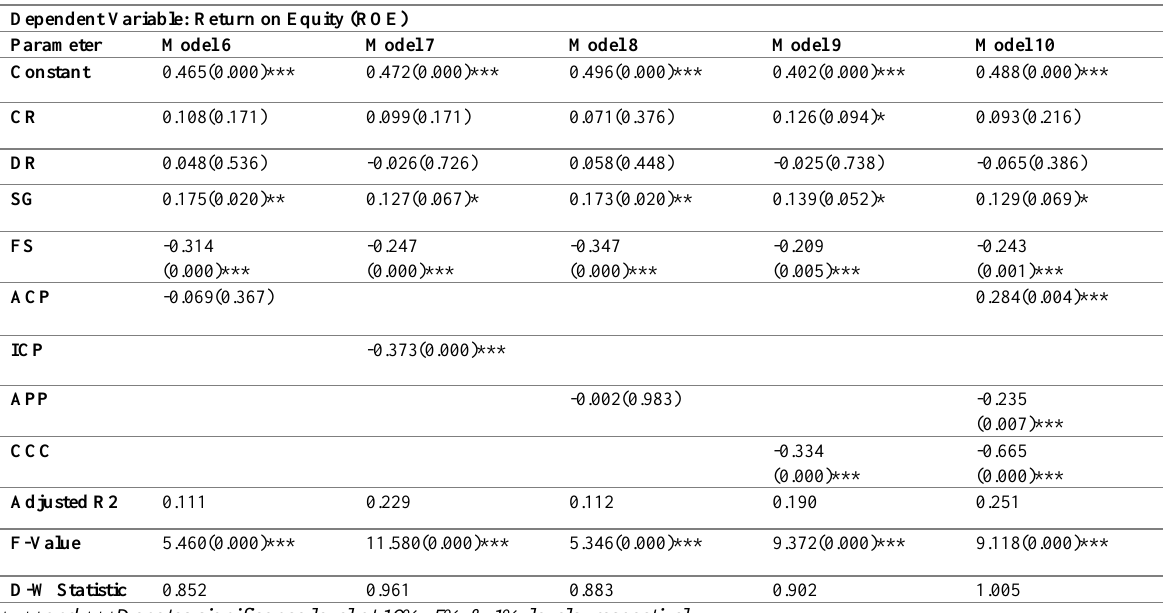
Table 4: Regression Result for Dependent Variable